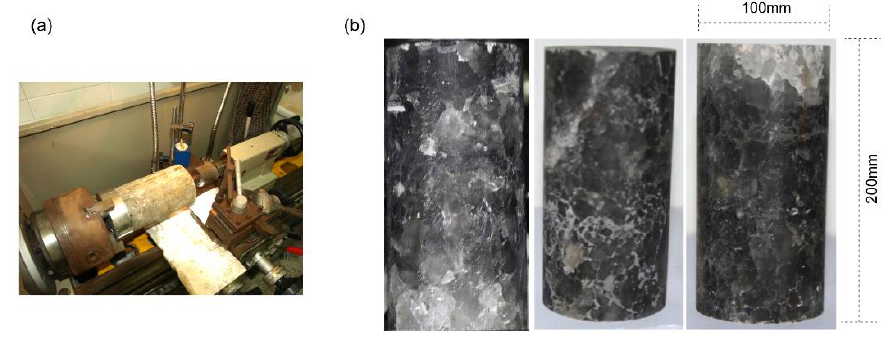
Figure 2. Salt samples for testing. ( a ) Rock cutting machine; ( b ) standard cylinder samples with a diameter of 100 mm and a length of 200 mm.